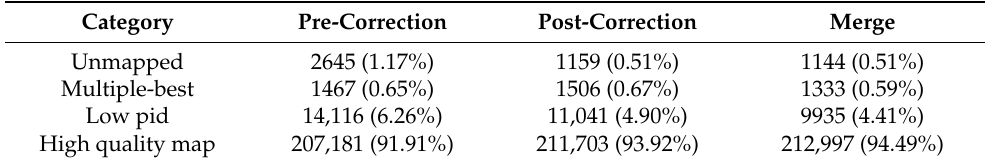
Table 3. Summary FLNC reads identified from full-length sequencing when aligned to reference genome.